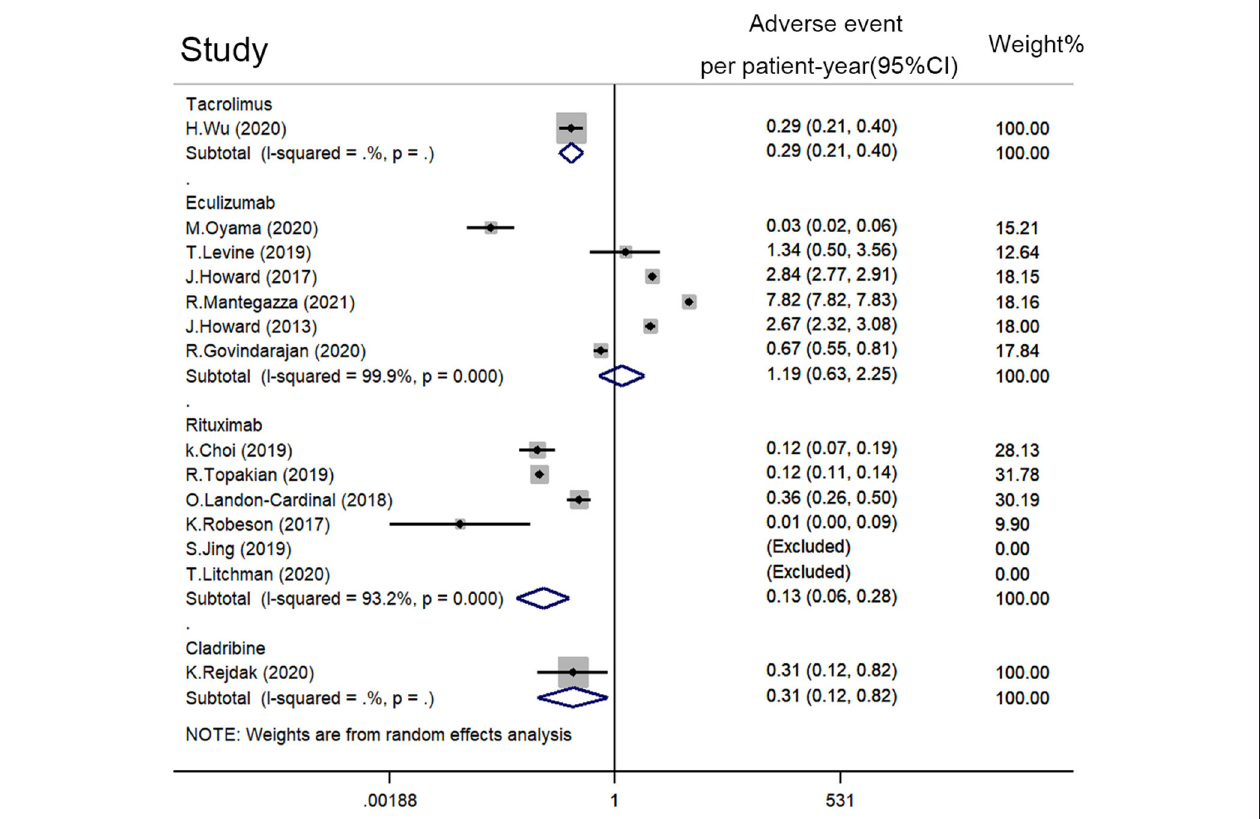
FIGURE 5 | Adverse event density (event rate per patient-year) of rituximab, eculizumab, tacrolimus, and cladribine on refractory MG. A random-effect model was used for the quantitative synthesis. Note that eculizumab had more adverse events than rituximab and tacrolimus. Besides, no significant difference in adverse event density between rituximab, tacrolimus, and cladribine was revealed.